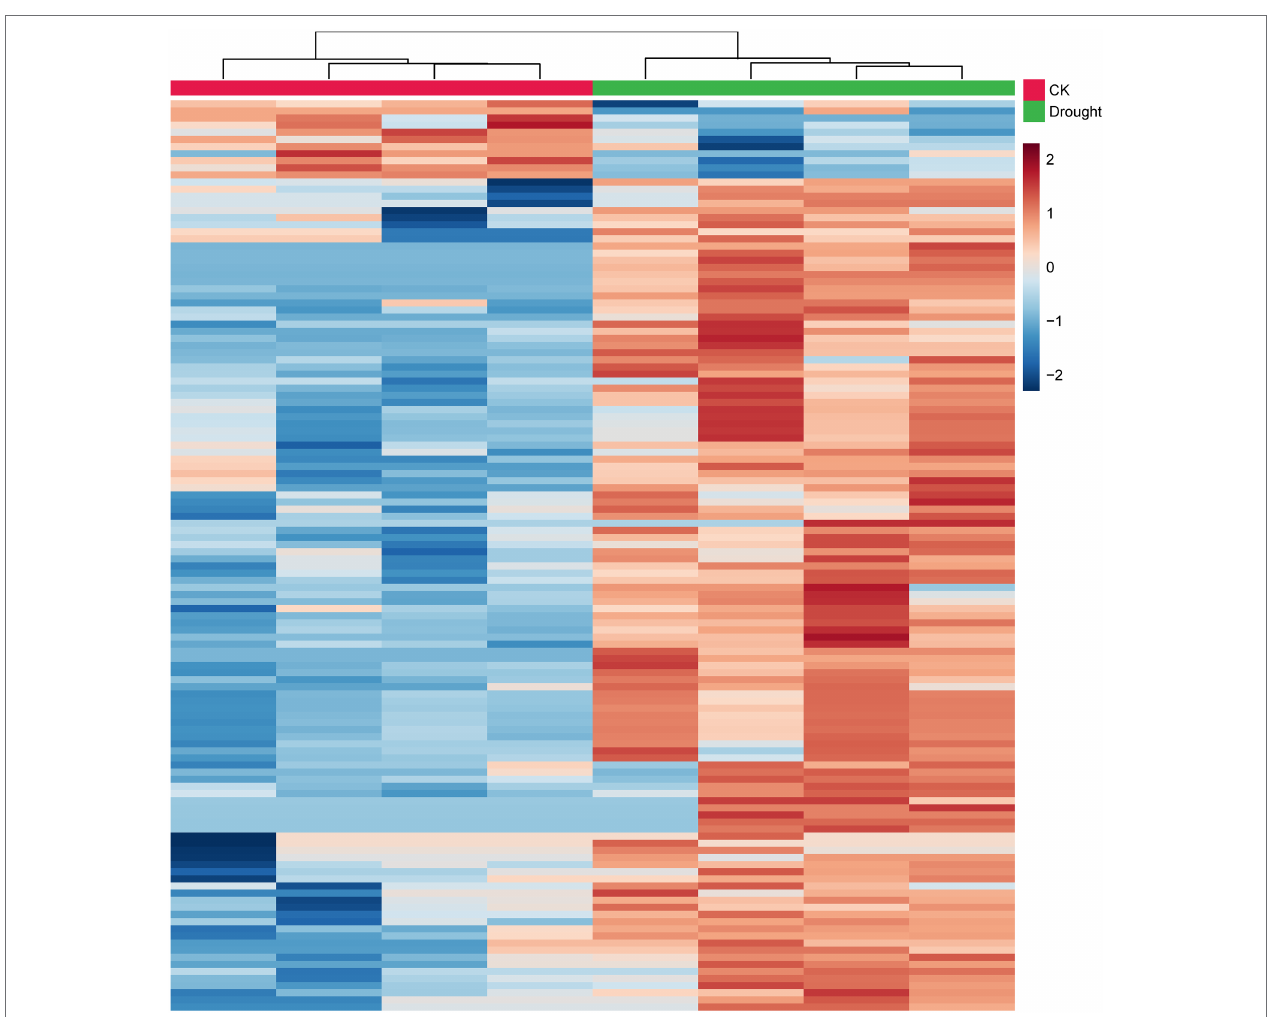
FIGURE 3 | Heatmap clustering of the relative contents of the 129 differential metabolites of C. breviculmis . Each row represents a metabolite and each column represents a sample. The warmer color indicates higher content and the colder color denotes lower